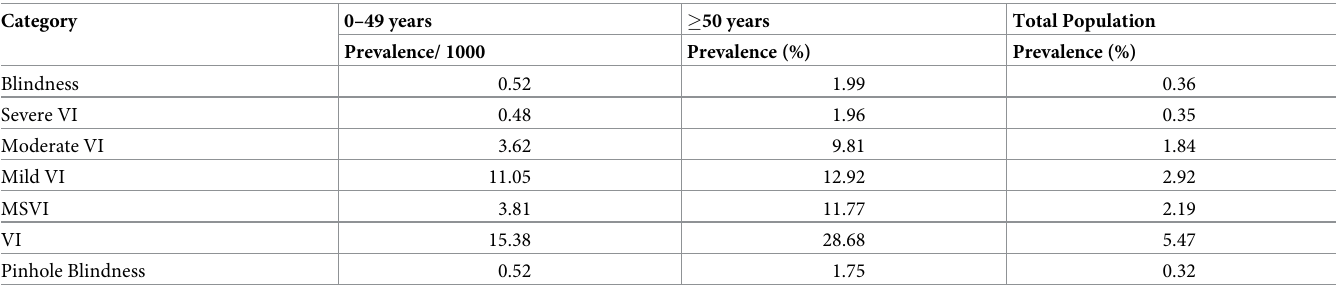
Table 5. Prevalence of blind and visually impaired in overall population of